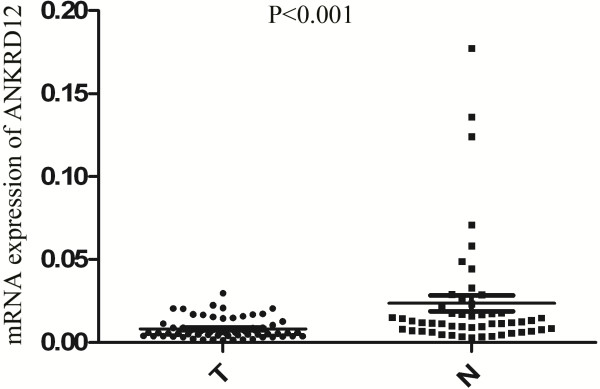
Quantitative reverse transcription-PCR showed mRNA expression of ANKRD12 in CRC tumor tissues (T) and adjacent normal mucosa (N). ANKRD12 expression levels were lower in tumor tissue than in normal adjacent mucosa (p < 0.001, Student’s t test).